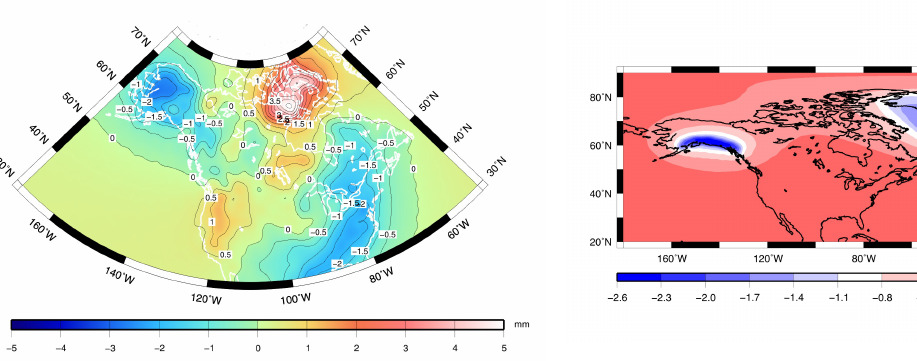
Figure 5. RateofthegeoidchangeduetoicemasslossinGreenland and Alaska; unit is mm/yr. areas. The GRACE rates and GNSS velocities can be combined op- timally by means of least-squares adjustment where the velocity surface is parameterized using local radial-base functions placed uniformly in the area of interest. The computational procedure is described in detail by Rangelova et al.